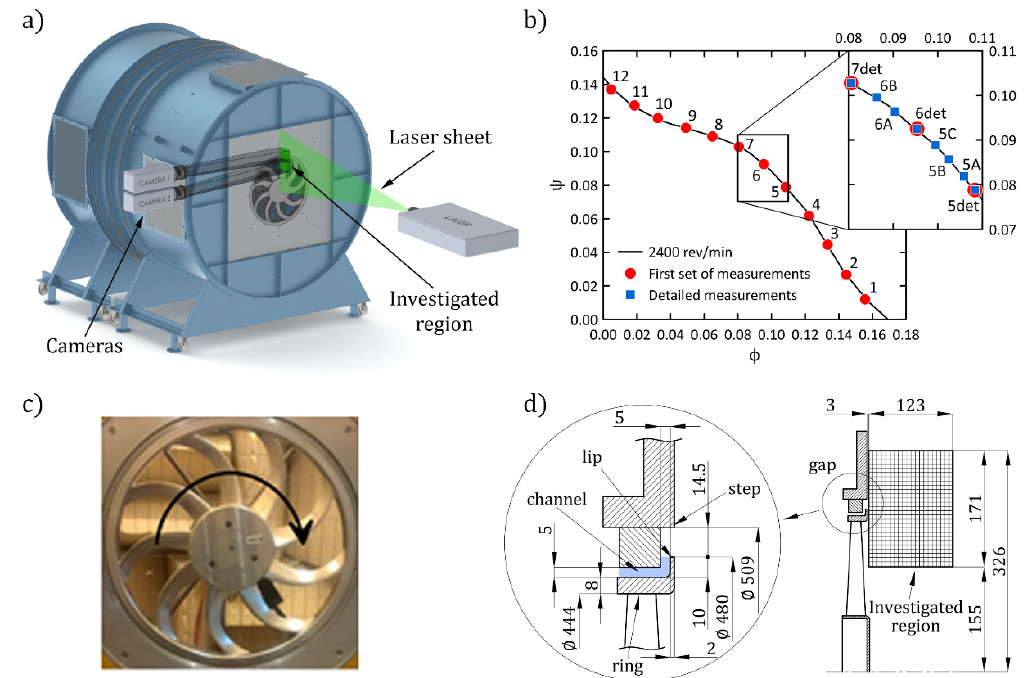
Figure 1. Experimental facility: ( a ) test rig; ( b ) rotor characteristic curve and investigated conditions; ( c ) rotor prototype; ( d ) rotor geometry.